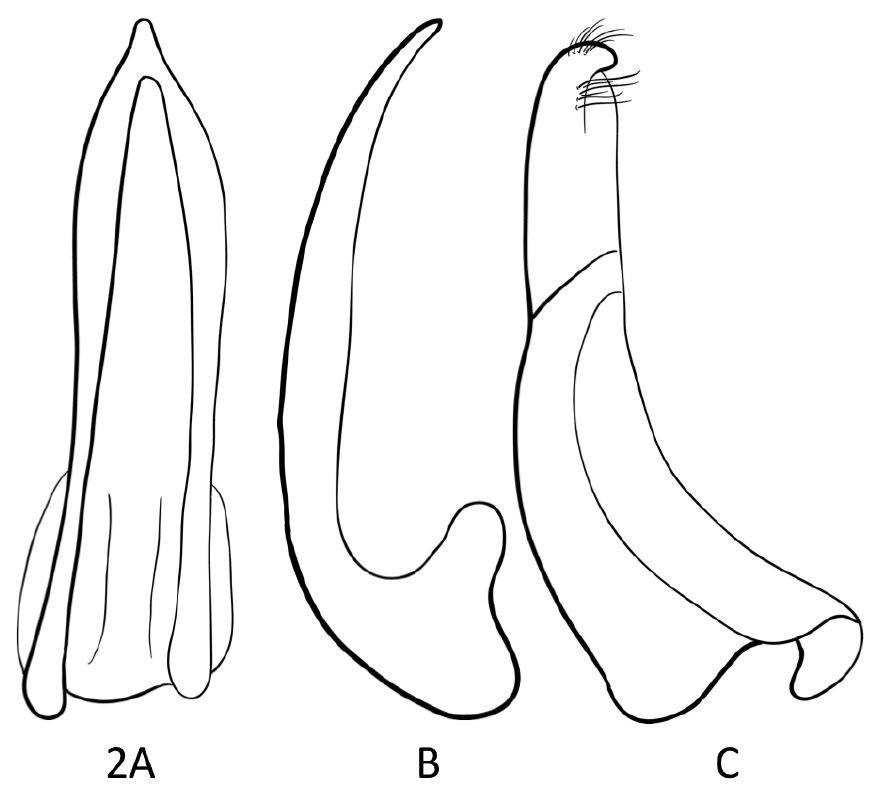
Figure 2. Rompindessus jenisi gen. et sp. n., holotype, median lobe of aedeagus, ventral view ( A ), lateral view ( B ), paramere, lateral view ( C